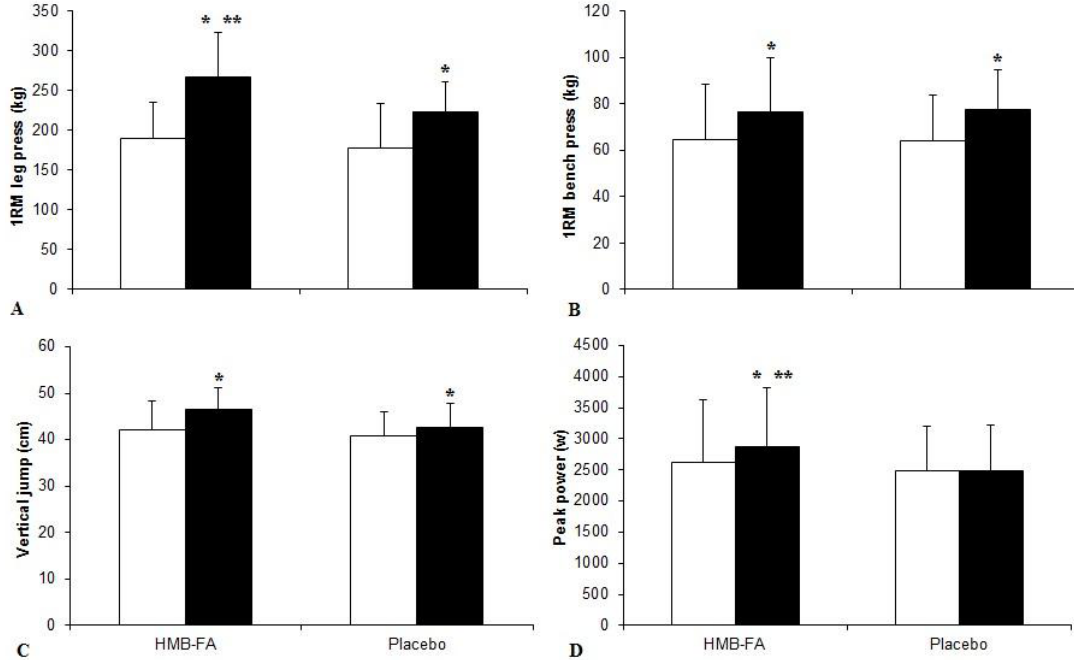
Figure 1. Changes in strength and power following six-week training intervention (mean ± SD). ( A ): 1RM leg press; ( B ) : 1RM bench press; ( C ) : vertical jump; ( D ) : peak power. *: denotes significant differences